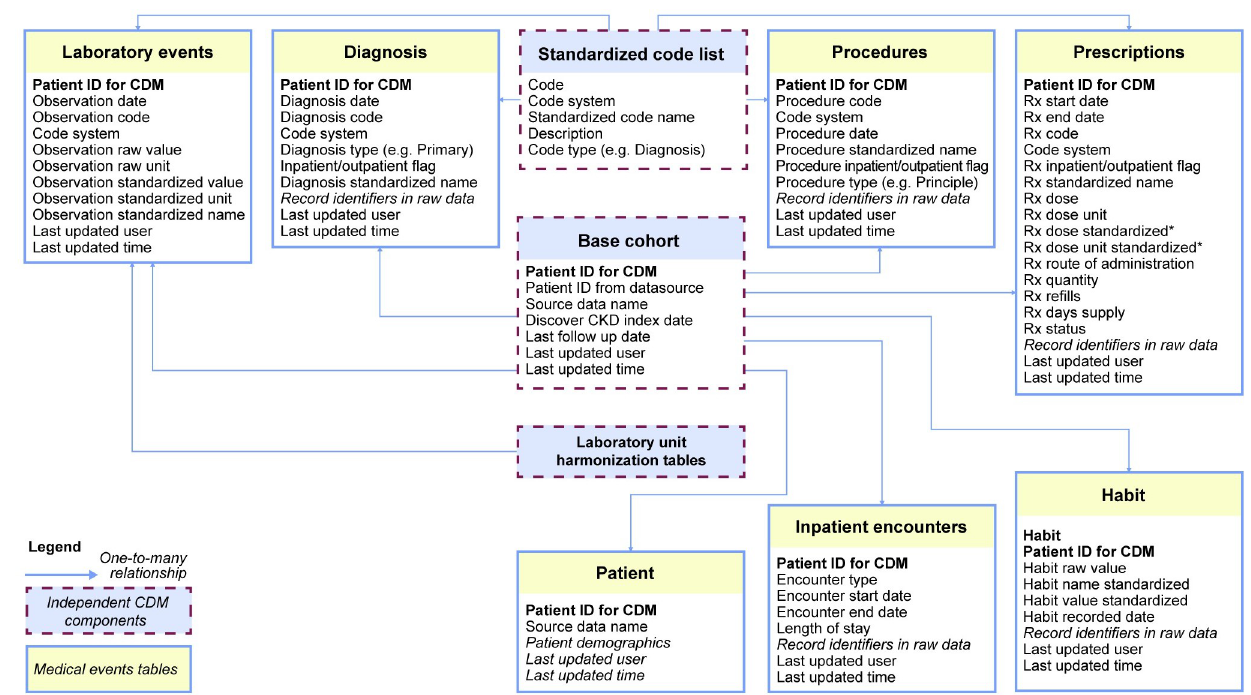
Fig 2. Simplified entity relationship diagram. � Prescription dose and dose standardization are pending. CDM, common data model; CKD, chronic kidney disease; ID, identification; Rx, prescription.